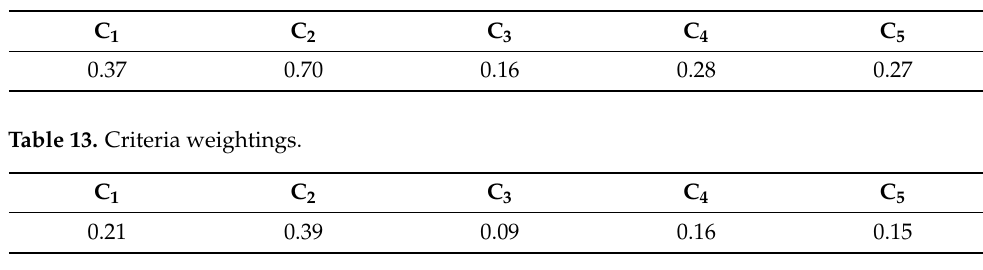
Table 12. Criteria scores.